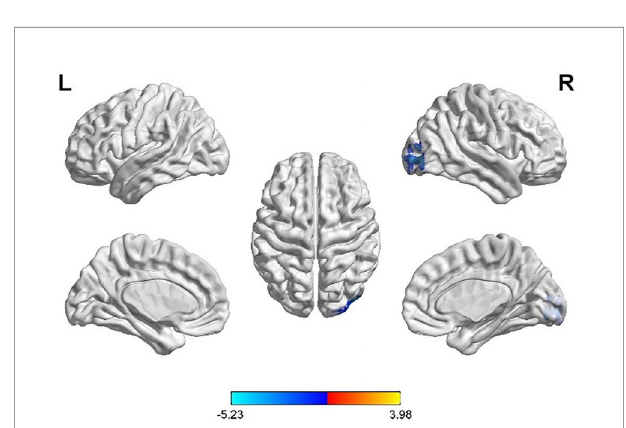
FIGURE 3 | Differences in left posterior cingulate gyrus (PCG.L) based FC between women with polycystic ovary syndrome and controls (the peak level threshold was set at p = 0.001; cluster level FDR-corrected, p < 0.05). All the FC strengths were increased and marked in red.